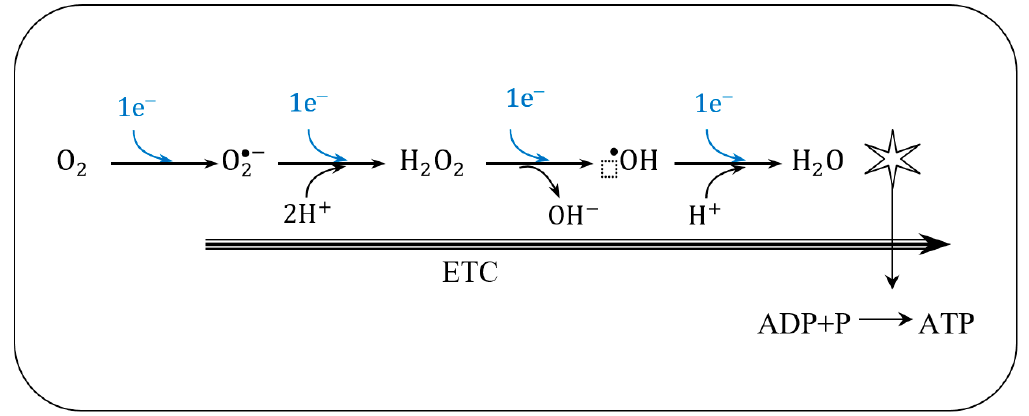
Figure 6. Schematic illustration of - Series of one-electron reaction that occurs during the ETC process.